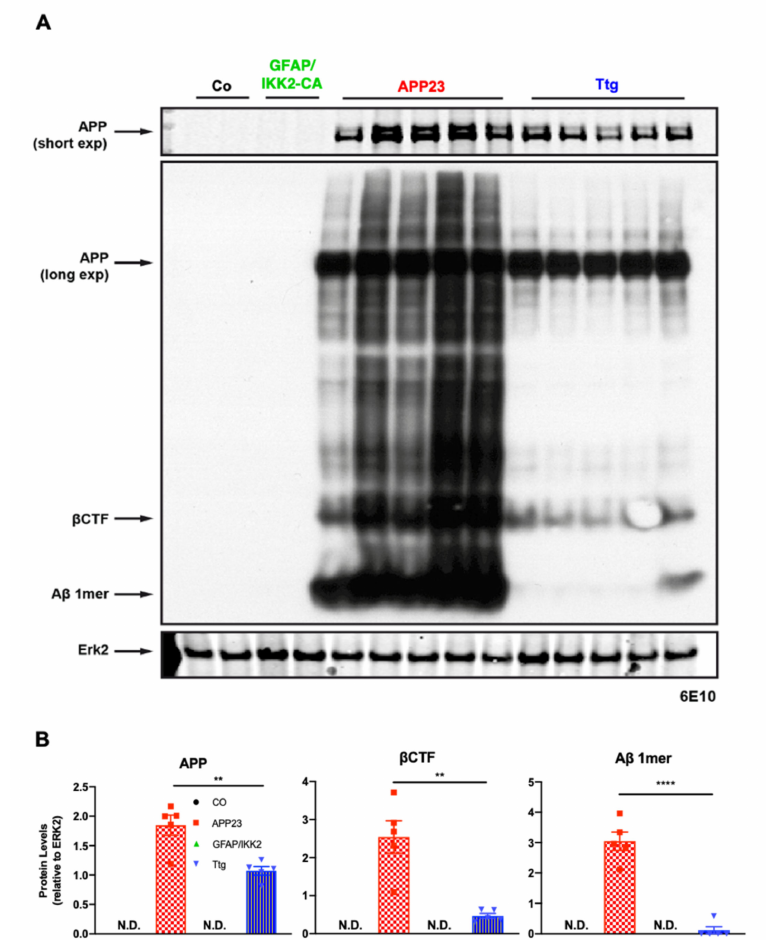
Figure 4. Astrocytic-driven neuroinflammation in the APP23 animal model induces amyloid protein level reduction in Ttg mice. ( A ) Western blot assessment of insoluble Lämmli-Urea (LU) protein fraction of A β burden in cortical extracts from Co, APP23, GFAP/IKK2CA, and Ttg mice, tested with antibody against human APP (6E10). Long exposure immunoblot shows expression of huAPP (6E10), β -CTF and monomeric A β in a “smear” form. ( B ) Quantification of huAPP (short exposure) revealed that APP levels are decreased by 50% in Ttg mice compared to APP23 littermates, whereas β -CTF and monomeric A β levels were massively decreased. Quantification of huAPP (6E10), β -CTF and monomeric A β was normalized to Erk2 (used as loading control). Statistical analysis: Student’s t -test (** p = 0.01; **** p = 0.0001); Exp = exposure; N.D. = Not detectable; β CTF = Beta C-terminal fragment; A β 1mer = monomeric A β